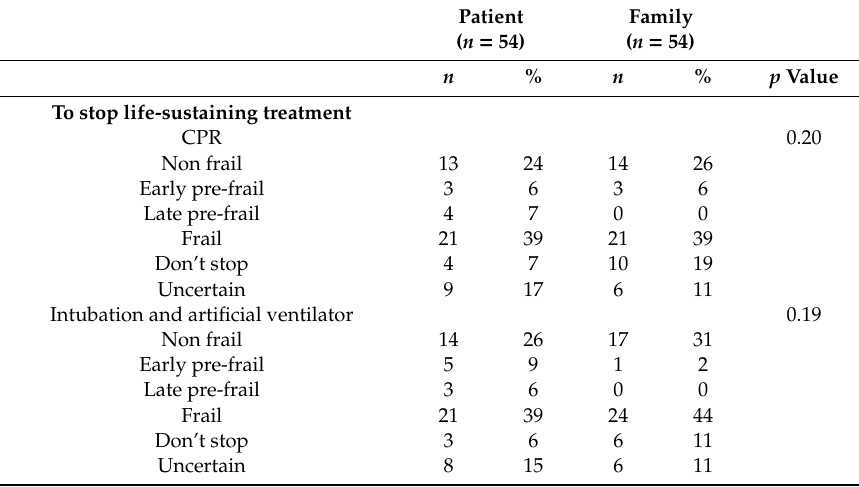
Table 3. Comparison of the preferred timing for life-sustaining treatments (CPR, intubation and artificial ventilator, artificial nutrition and hydration, antibiotics, blood transfusion and hemodialysis) withdrawal between patients and family caregivers and their perceptions on advance care